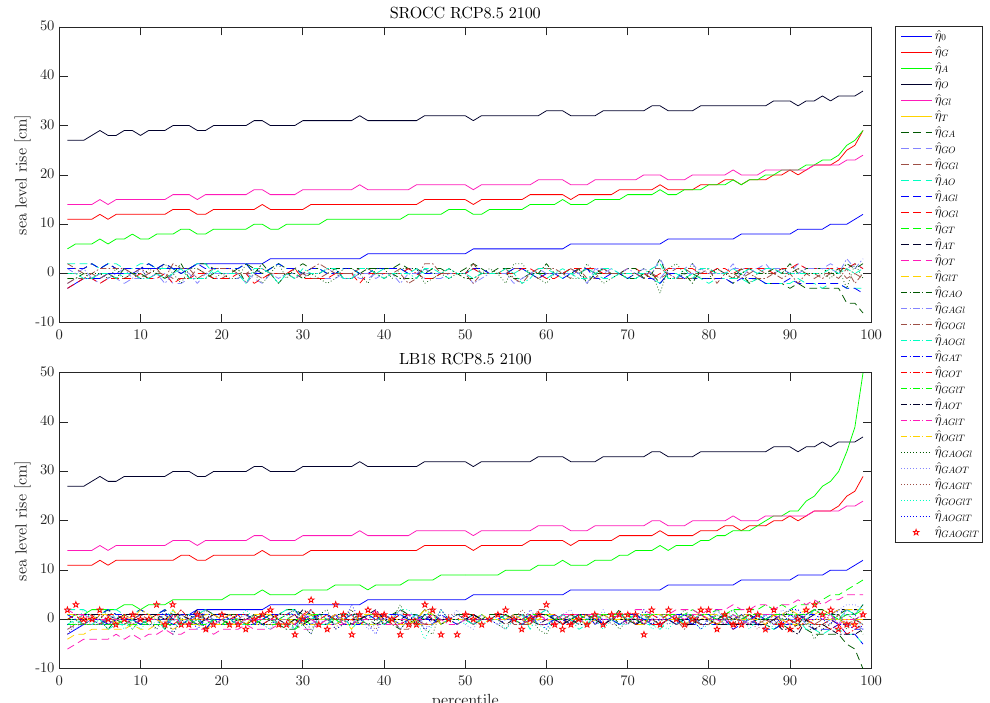
Figure 2. Factorisation of the RCP8.5 projections from the SROCC and LB18 models. Percentiles between 1 and 99 are shown. Note also that the SROCC factorisation has 16 terms, while the LB18 factorisation has 32 terms owing to the inclusion of the γ constant multiplying GMST. A hat variable with one subscript shows the direct effect of one process, while a hat variable with multiple subscripts show the effect of the interaction between these processes. The subscript 0 stands for terrestrial water change, G for Greenland, A for Antarctica, O for ocean and Gl for